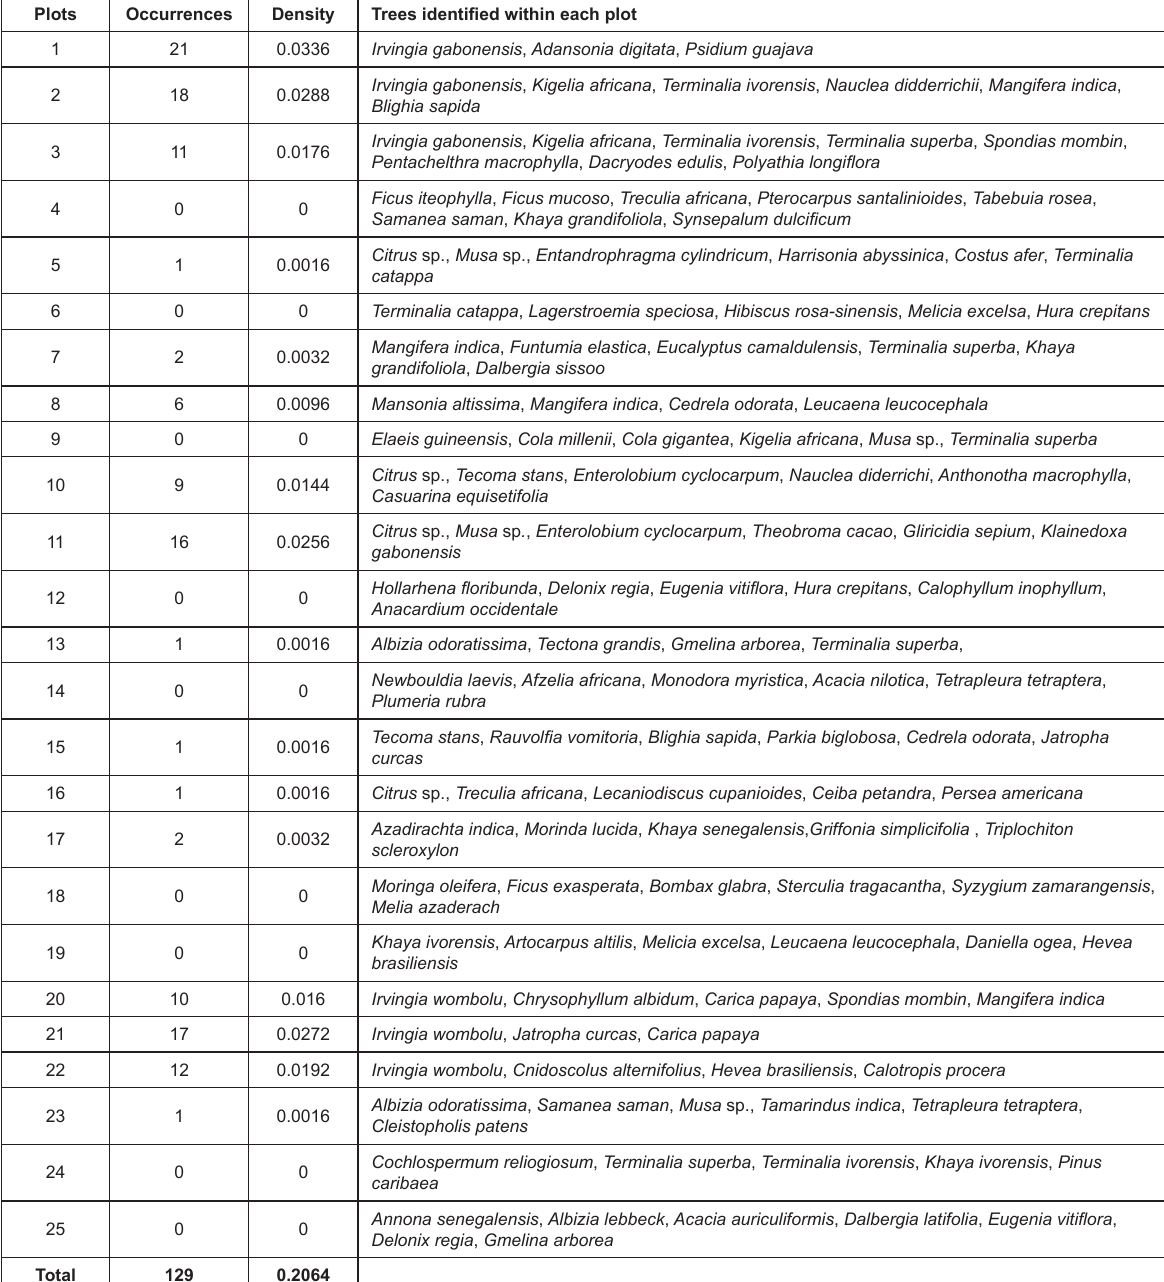
Table 1. Occurrences of Aerangis biloba within the 25 plots